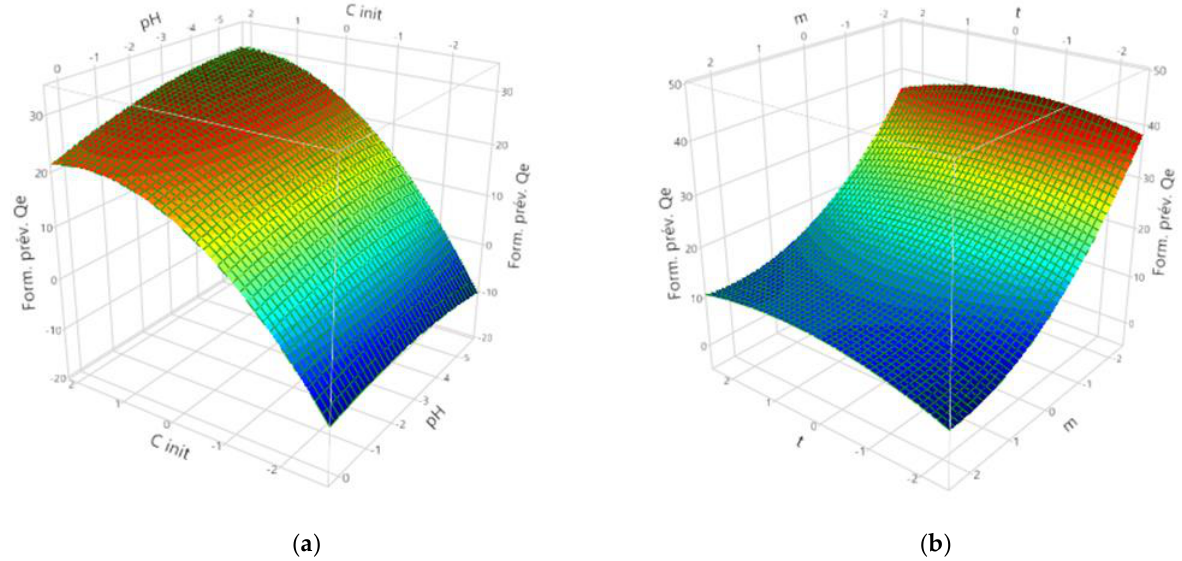
Figure 8. Representation of the response surface in three-dimensional space. ( a ) Interactive effect of 332 initial concentration and pH. ( b ) Interactive effect of contact time and mass of adsorbent.